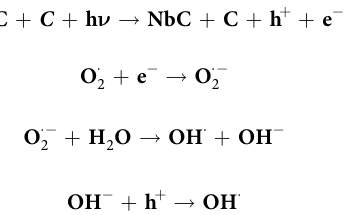
which maneuvers the practical usefulness of photocatalyst. To observe the reusability and stability of as-prepared C coated NbC NPs, recycle reactions were carried out for the degradation of all the dyes over 10C800 as shown in Fig. 14b. To observe the recyclability of as prepared photocatalyst, previously used photo catalysts (10C800) were removed from the solution by centrifugation and then reused for the photodegradation of all the dyes with the same concentration of the solution and irradiation intensity. The excellent stability of photocatalyst (10C800) is well-illustrated from the XRD pattern of 10C800 after the 3 rd cycle of photodegradation reaction as shown in Fig. S10. These results suggest sufficient stability of the photocatalyst during photodegradation of the dyes and can be reused without significant decrease in performance. To establish the mechanism responsible for such a good photocatalytic behavior of synthesized photocatalyst, the generation of reactive oxygen species (ROS) has to be confirmed by using e − , h + , OH · and ⋅− O scavengers. As 2 an effect of these scavengers, degradation of dyes got retarded differently, which is shown in Fig. 15. In case of RhB dye, the addition of AO (hole scavenger) in dye solution retarded the degradation rate by 38% as compared to other scavengers and degradation of MB dye was reduced by 15% with the addition of SS, IPA, and AO (Fig. 15a,b, respectively). Furthermore, addition of superoxide free radical scavenger i.e. AA does not affect the degradation of MB dye. On the other hand, degradation of MO dye was affected significantly in the presence of scavengers among which IPA reduced the efficiency by 33% which is higher than other scavengers (Fig. 15c). The observed retardation in photocatalytic degradation of different dyes can be correlated with the generation of the above-mentioned ROS. Degradation mechanism. Figure 16 illustrates the proposed mechanism responsible for the photocatalytic degradation of dyes under visible light irradiation. As per the XRD results, it cannot be stated that nanocomposite sample consists of NbC alone, but, presence of O-centers (observed form TEM and XPS analysis) inside the NPs induced the optical active sites generating the charge carriers upon visible exposure. Earlier, Ohgi et al . 75 and Ishihara et al . 76 also suggested the enhanced generation and transportation of charge carriers by inducing oxygen centers (through partial oxidation) in the carbide nanoparticles. Figure S11 shows the valence band XPS spectra of 10C800 and 5C800 depicting different VB edges of ~1.97 and ~1.71 eV and with the help of optical absorption analysis, the position of the CB can be estimated. The CB edge potential of both the samples ( − 0.15 eV and − 0.38 vs NHE, respectively) are more negative than the standard redox potential of − O /O ( − 0.046 eV vs NHE) to 2 2 reduce molecular oxygen 77 . Further, VB potential edge of − . OH /OH ( + 1.99 eV vs NHE) is lower than VB of pho- tocatalyst 77 . Being metallic in nature, NbC supported the charge transfer towards the surface of NPs where the reaction with the hydroxyl anion and dissolved oxygen in water produces hydroxyl free radicals ( ⋅ OH ) and super- ), respectively. These reagents are considered as strong oxidizing agents and thus oxide free radical anions ( .− O 2 oxidize the dyes adsorbed on the surface of the NPs. Various reactions, which are responsible for the degradation of dyes and are expressed as follows: ν +